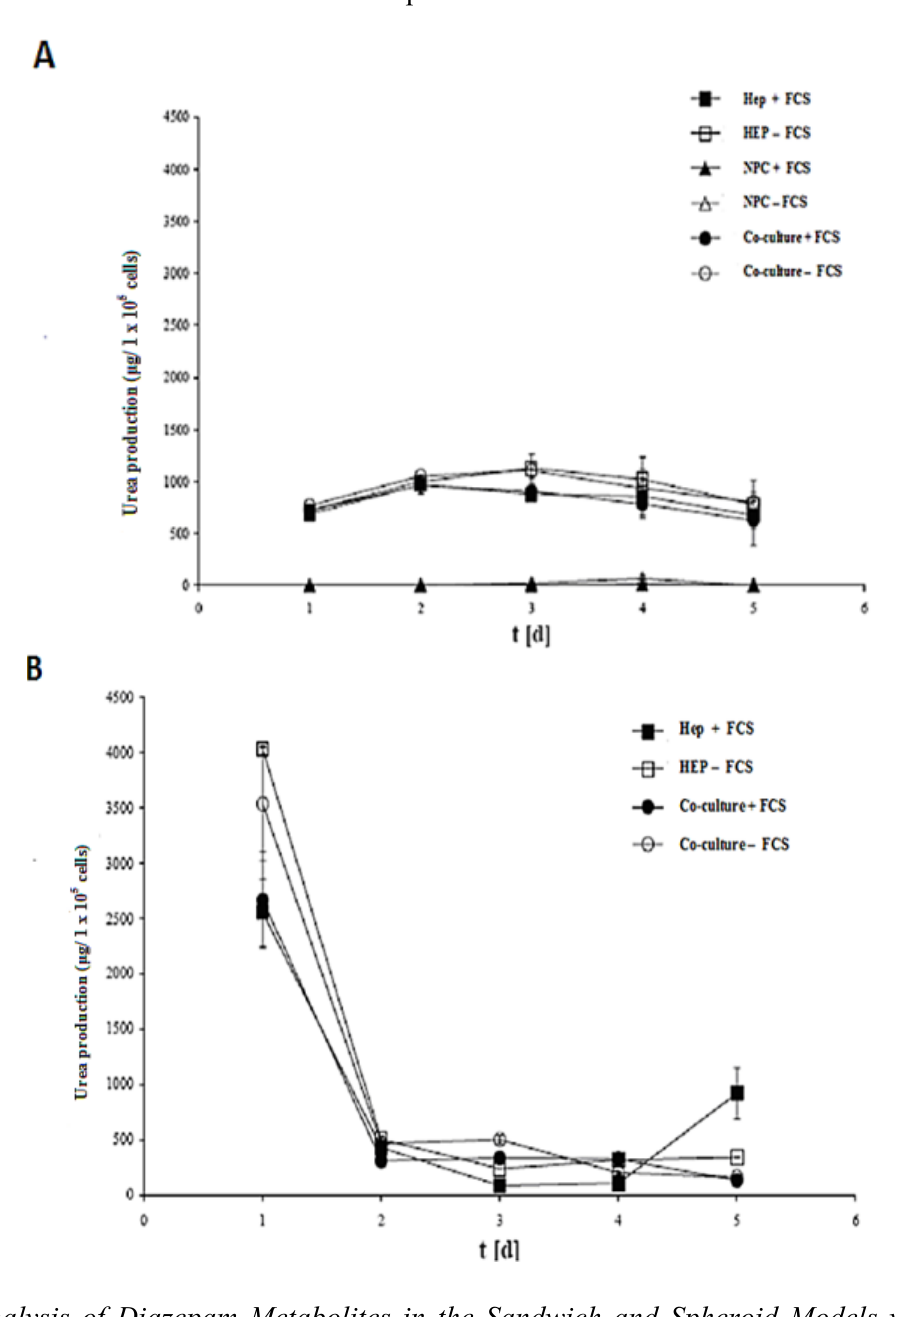
Figure 9. Urea productions in the sandwich and spheroid culture. (A) Total urea production of the cells in serum-free and serum-containing mono-and co-cultures in the sandwich model; Hep + FCS, HEP – FCS, NPC + FCS, NPC – FCS, co-culture + FCS, co- culture – FCS. (B) Total urea production of the cells in serum-free and serum-containing mono-and co-cultures in the spheroid model; Hep + FCS, HEP – FCS, co-culture + FCS, co-culture – FCS. Each point represents the mean ± S.E.M. of five experiments during which LDH activities were measured in